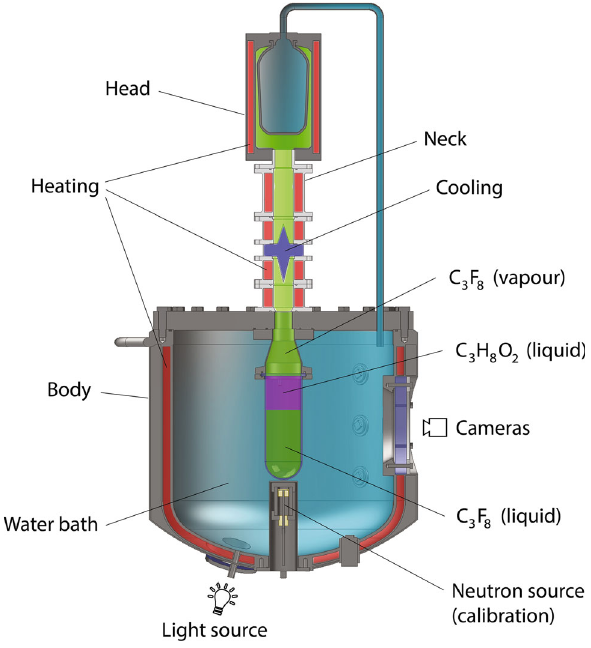
Fig. 1 The MOSCAB bubble chamber. The shown 2 L vessel can be replaced by the 25 L one